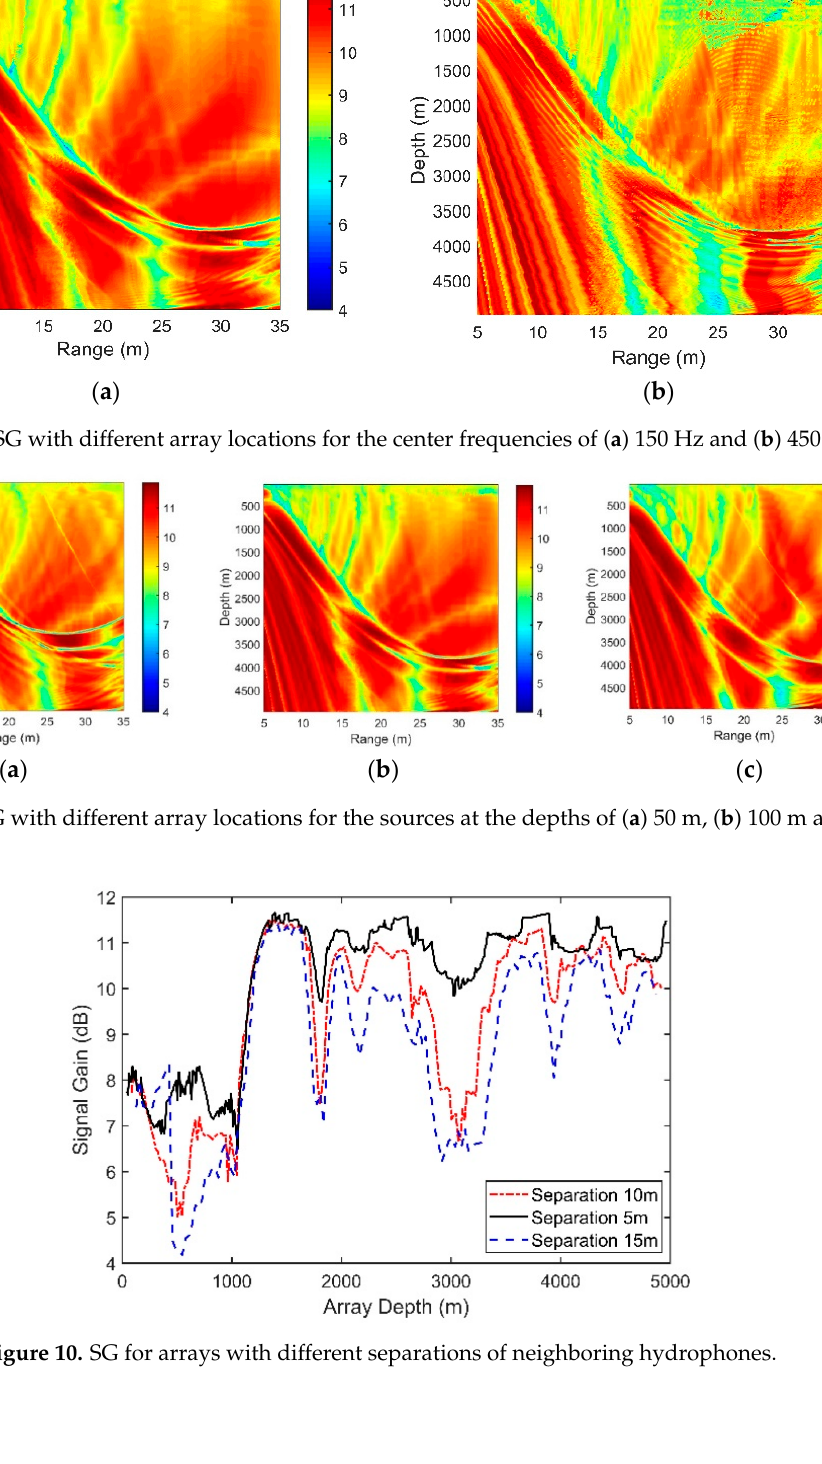
Figure 10. SG for arrays with different separations of neighboring hydrophones.